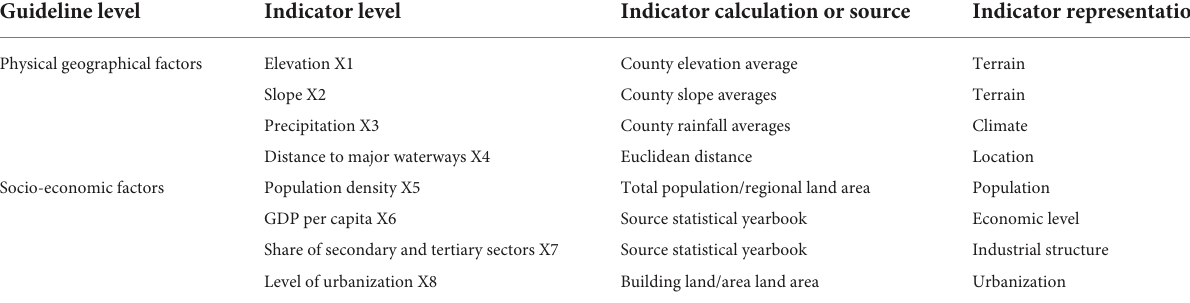
TABLE 2 Original variables influencing the transformation of farmland